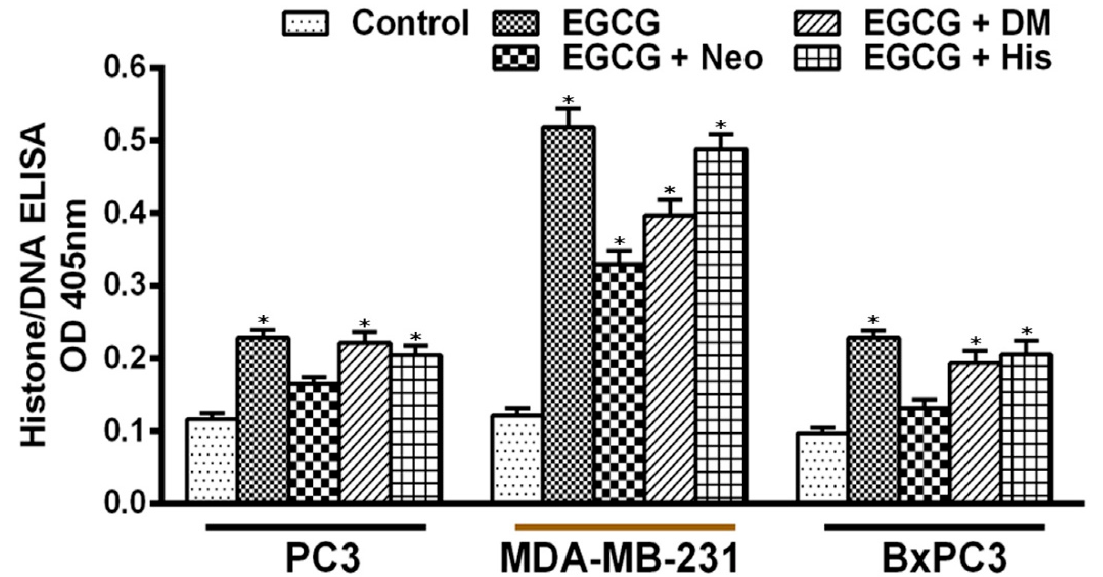
Figure 5. Effects of different metal chelators on apoptosis induction by EGCG in three different cancer cell lines. PC3, MDA-MB-231, and BxPC3 cancer cells were treated with 25 µM of EGCG either alone or in the presence of copper chelator neocuproine (Neo), iron chelator desferrioxamine mesylate (DM), or zinc chelator histidine (His), as indicated in the figure. The concentration of metal chelators used was 50 µ M. An MTT assay was performed after 72 h of treatment as described in the Materials and Methods section. Values reported are ± S.E. of three independent experiments. * p value < 0.01 when compared to